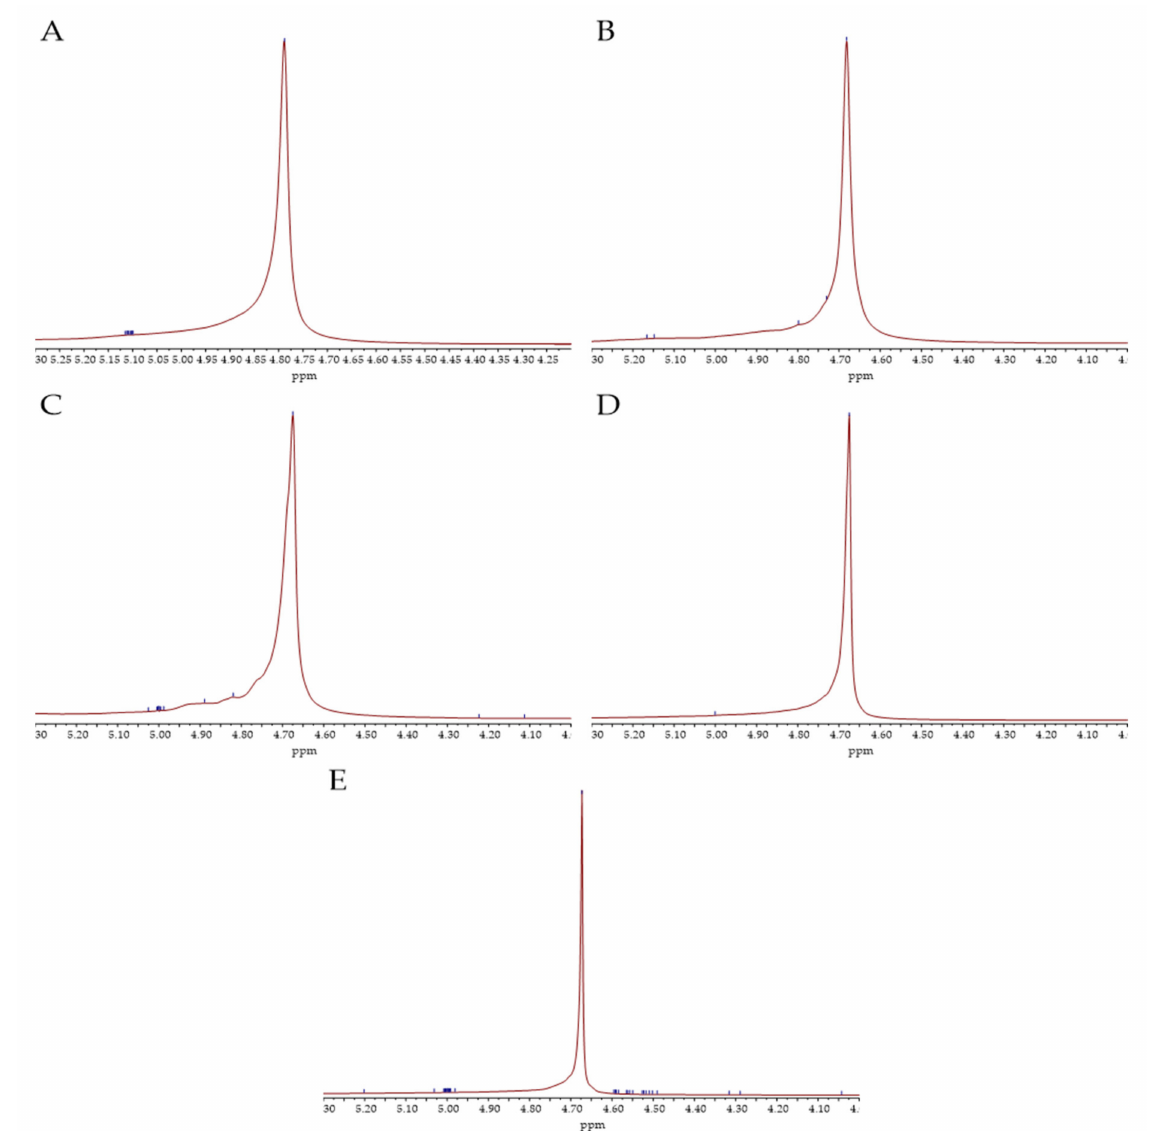
Figure 5. 1 H-NMR spectra of the extracted sodium alginate from P. boergesenii ( A ), T. triquetra ( B ), H. cuneiformis ( C ), D. ciliolata ( D ), and S. aquifolium ( E